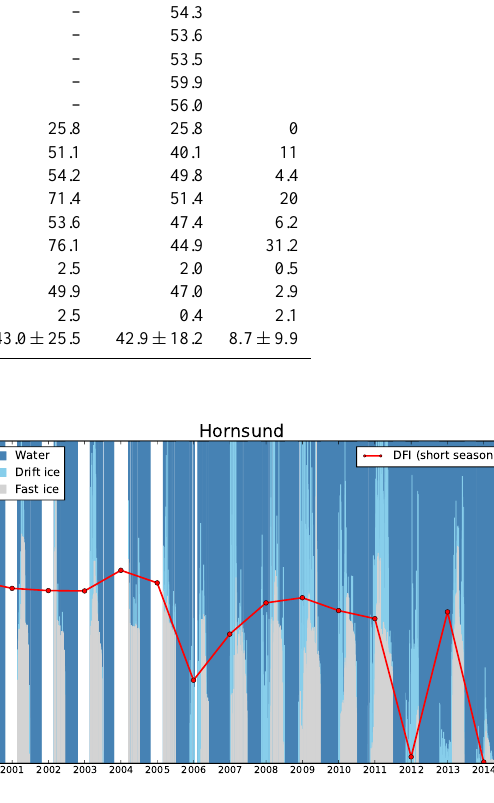
Figure 4. Surface coverage of Hornsund between 2000 and 2014 divided into “fast ice”, “drift ice”, and “open water” by a sea ice expert. Total area = 324.0km 2 (defined with Landsat image from 24 August 2013). White gaps occur when no satellite data were available. The red dots display the “days of fast ice” (DFI) values of the short season as shown in Table